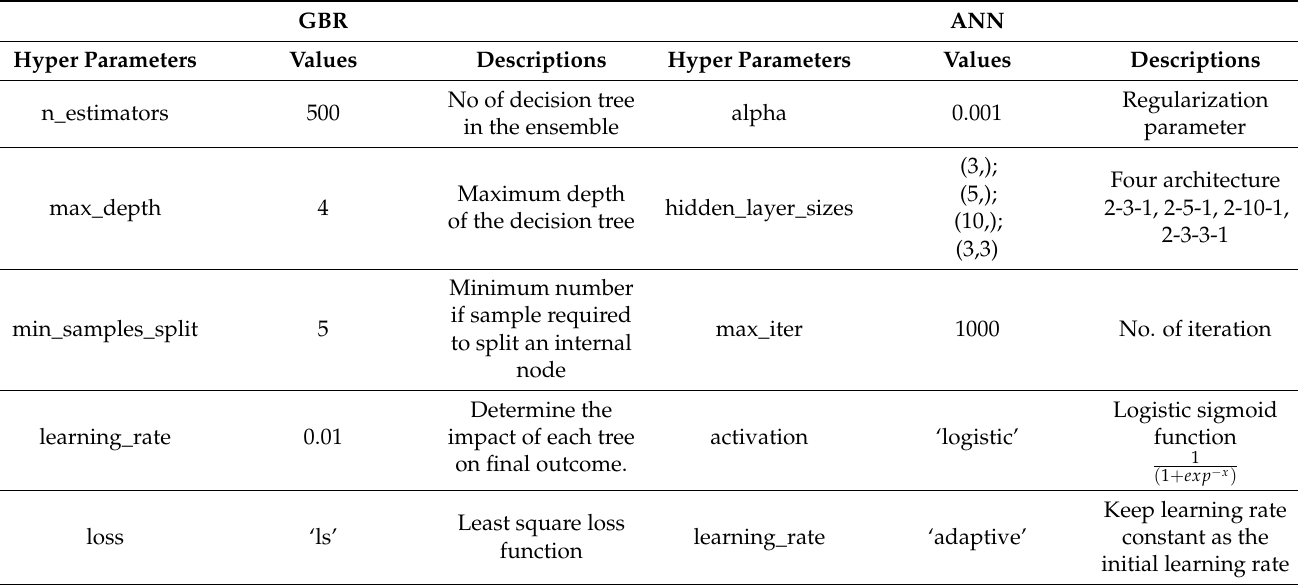
Table 3. Descriptions of hyperparameters tuned in GBR and ANN